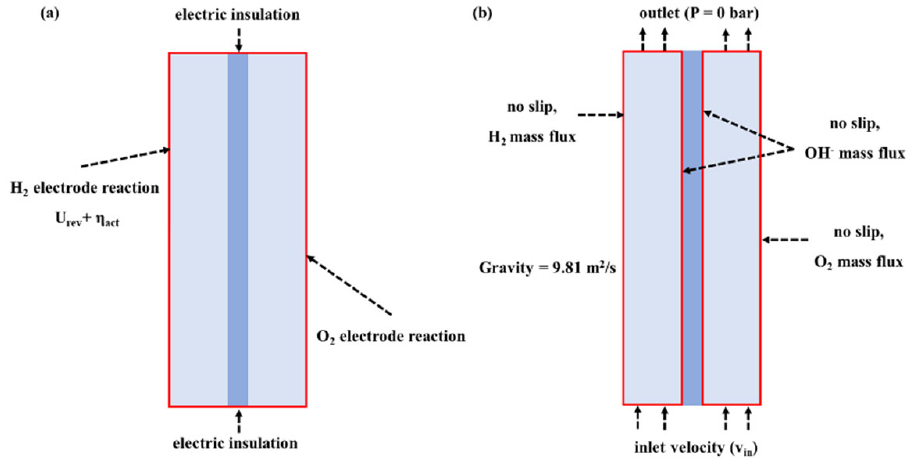
Figure 3. Boundary conditions of AWE. ( a ) Electrochemical model; ( b ) Hydrodynamic model. Because of the bubble effect, the conductivity of the KOH electrolyte will decrease, and the generated bubbles will cover the electrode surface, affecting the exchange current density of the electrode reaction. Therefore, the effective electrolyte conductivity and the effective exchange current density are described according to the Bruggeman equation, as shown in Equation (18) and Equation (19), respectively [28,33].